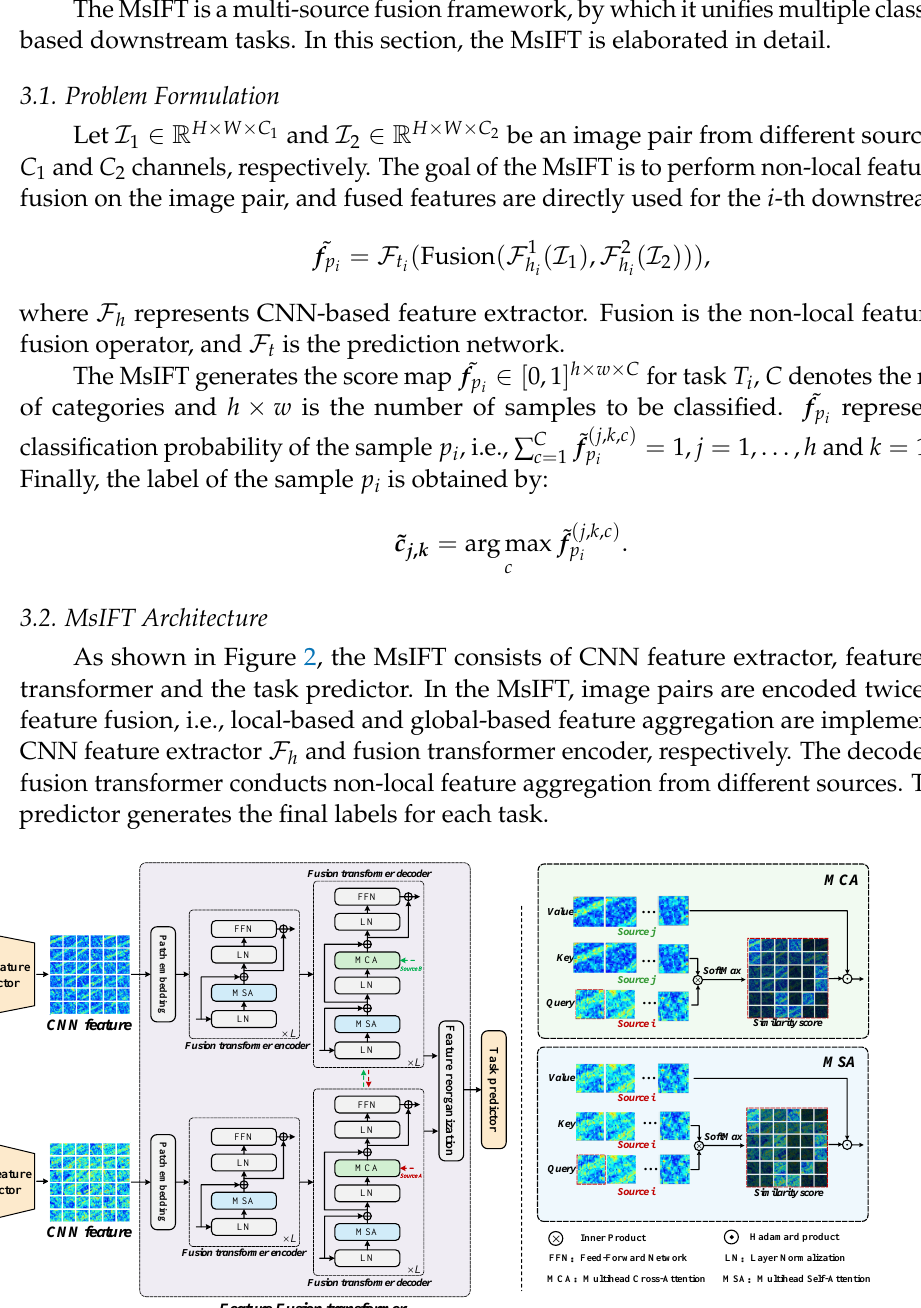
Figure 2. Overview of the proposed multi-source image fusion transformer (MsIFT). The MsIFT consists of the CNN feature extractor, feature fusion transformer and task predictor. The input images are first fed into the CNN feature extractor to obtain the local visual feature, the feature fusion transformer with encoder–decoder style structure is conducted to perform the global feature-level fusion. The prediction result is produced by the task